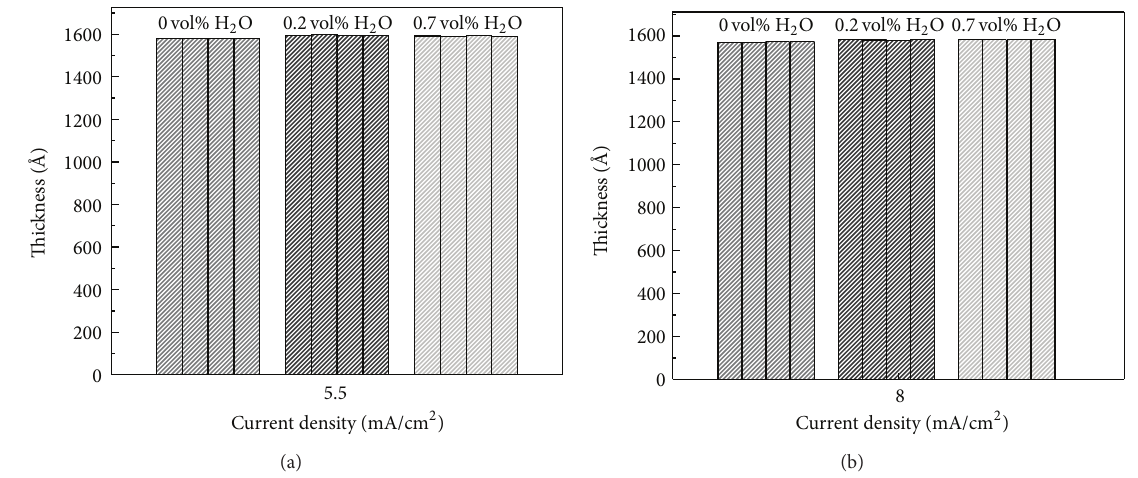
Figure 3: Thickness uniformity check by measuring film thickness at four different spots for the films grown in potentiodynamic mode at (a) 5.5 mA/cm 2 and (b) 8mA/cm 2 with varying water